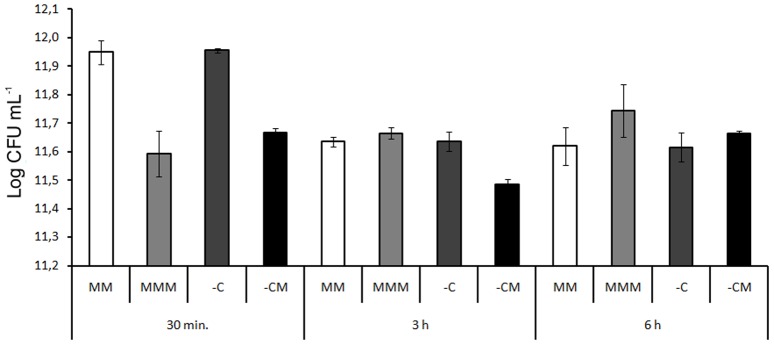
Cellular viability of E. coli DH5-α in MM and in the MMM, -C and –CM treatments, during the periods of 30 min., 3 h and 6 h.LSD = 0.13 for all pairwise comparison.